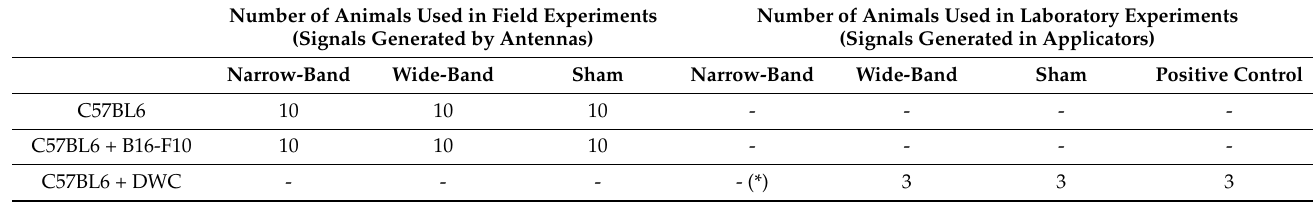
Table 1. Signal exposure protocols applied to healthy (C57BL6), tumor-bearing (C57BL6 + B16-F10), and dorsal chamber- bearing (C57BL6 + DWC) mice.